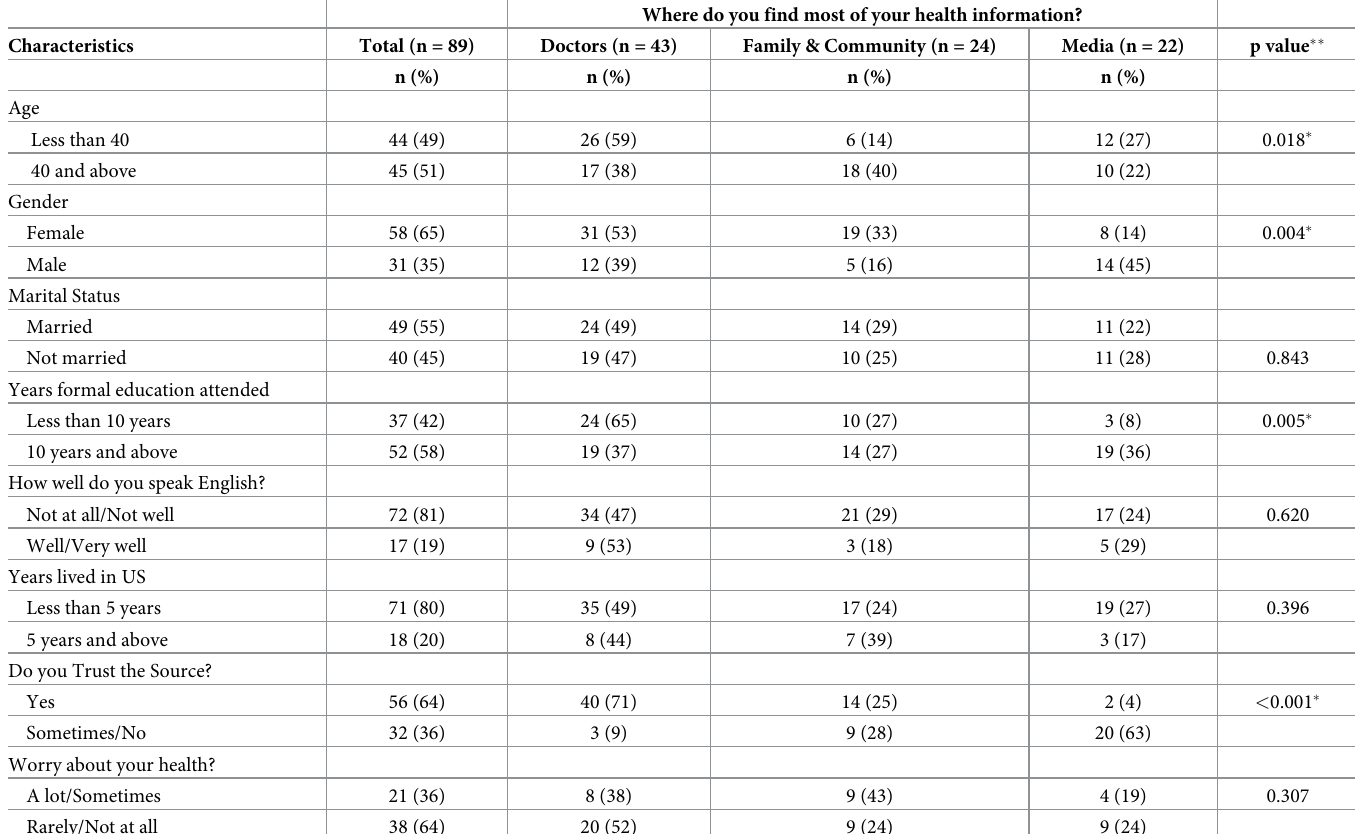
Table 3. Source of health information, by sociodemographic characteristics of Congolese building bridges participants, January 2018 –March 2020 (n = 89). Where do you find most of your health